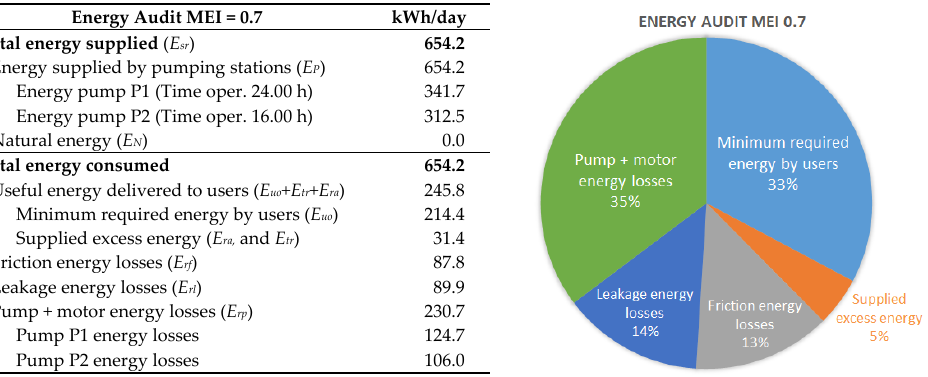
Figure 9. Energy audit result with a MEI = 0.7 pump (one CSP and one VSP).